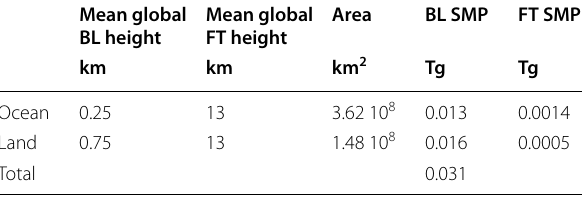
Table 3 Atmospheric small microplastics (SMP)